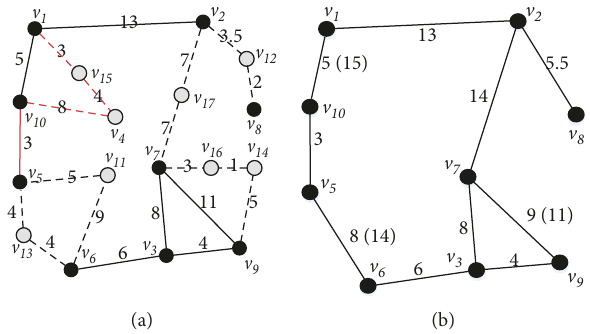
Figure 3: Backbone network. (a) Original network. (b) Backbone network